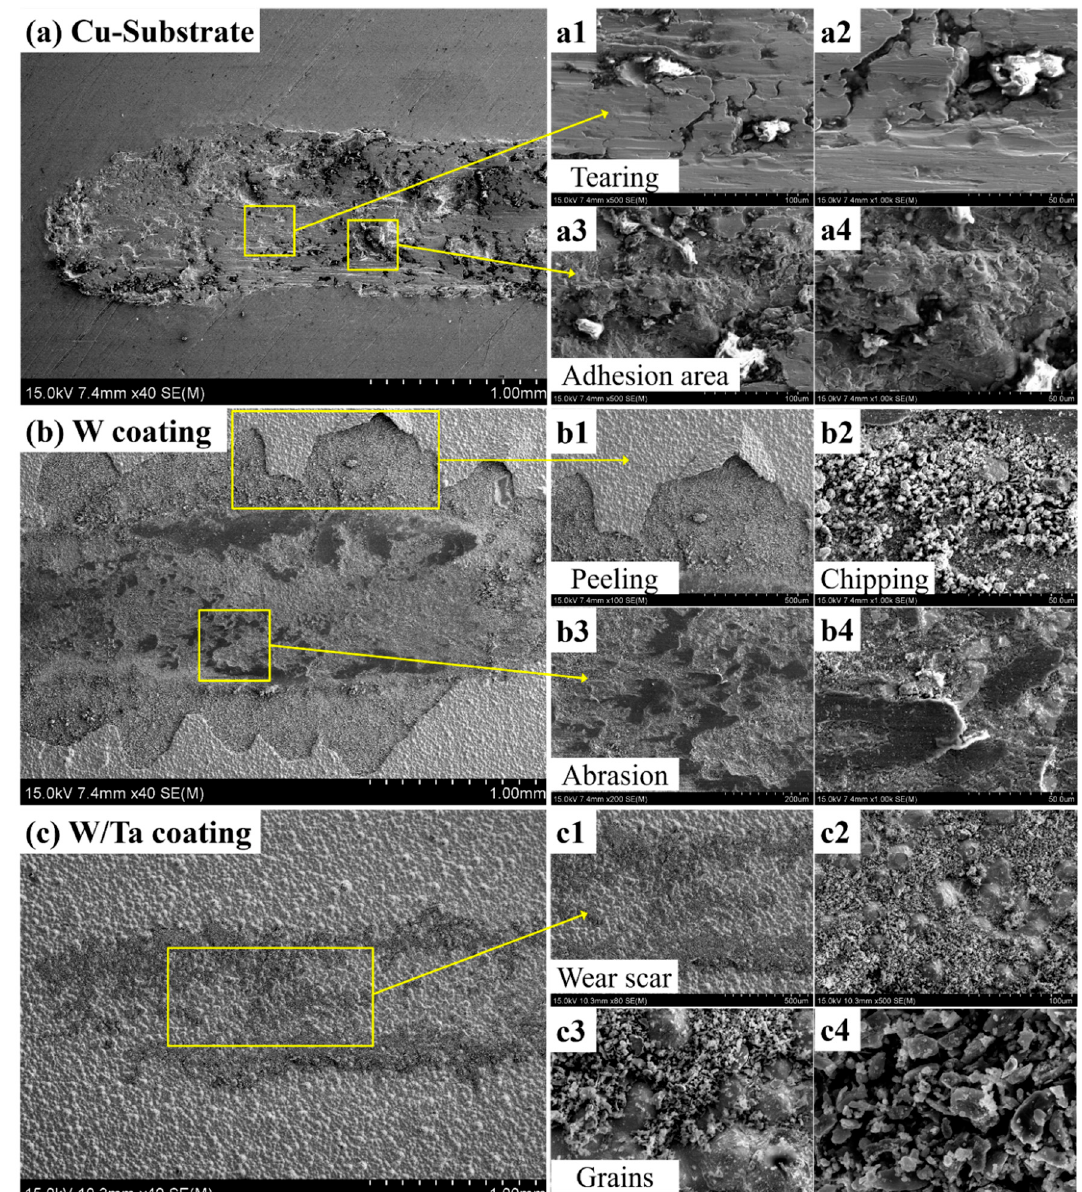
Figure 8. Morphologies of substrate and coated specimens after a tribological test at 25 °C: ( a,a1 – a4 ) Cu substrate, ( b,b1 – b4 ) W coating, and ( c,c1 – c4 ) W/Ta coating.